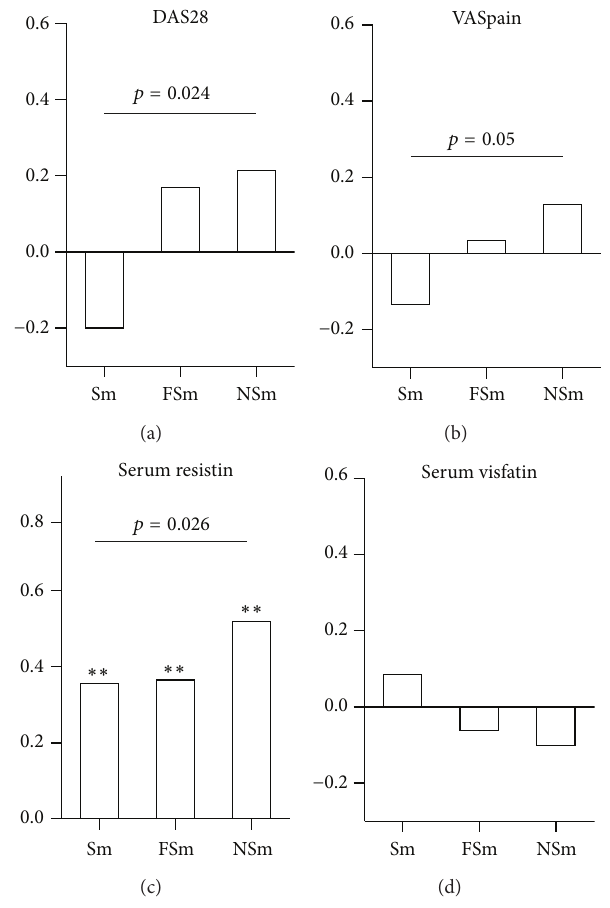
Figure 2: The correlations between serum levels of leptin and clinical parameters of RA in the smoking groups. The bars represent the correlation coefficients for the disease activity score (DAS28) (a), VAS-pain (b), and adipokine levels in serum (c, d) in RA patients grouped by smoking habits into smokers (Sm), former smokers (FSm), and never smokers (NSm). The correlations were analysed by the Spearman statistics. The Fisher’s 𝑟 -to- 𝑧 test was used to compare the magnitude of the correlation coefficients between Sm and NSm. The 𝑝 values below 0.01 are indicated ( ∗∗ ).